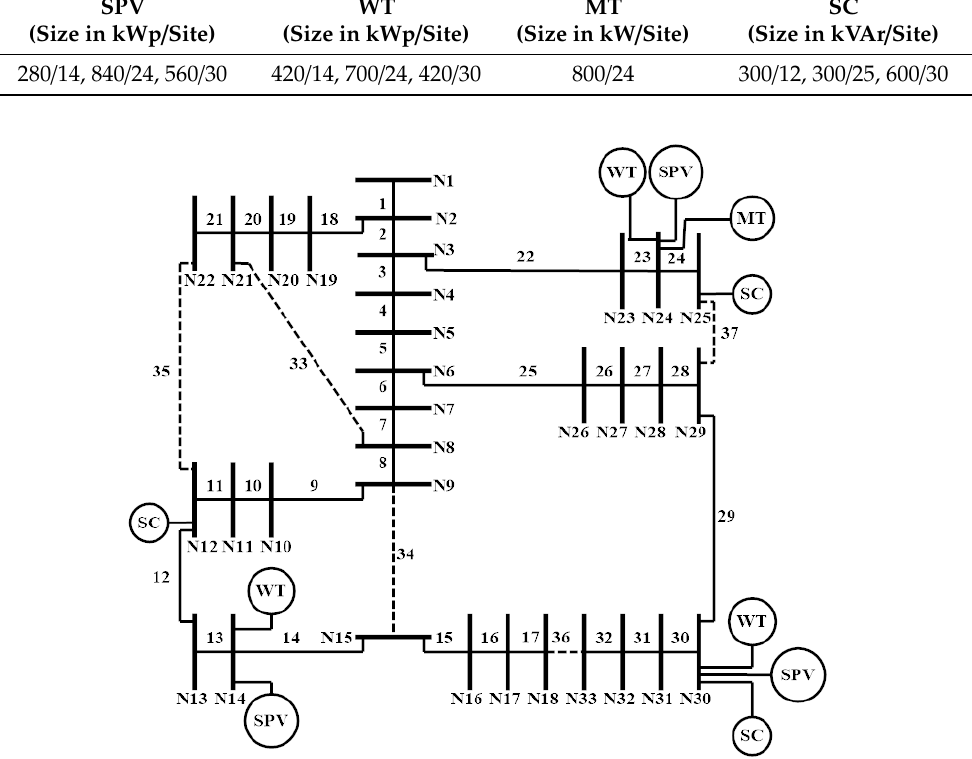
Figure 2. Modified 33-bus distribution system. Table 4. Load and generation factors used.